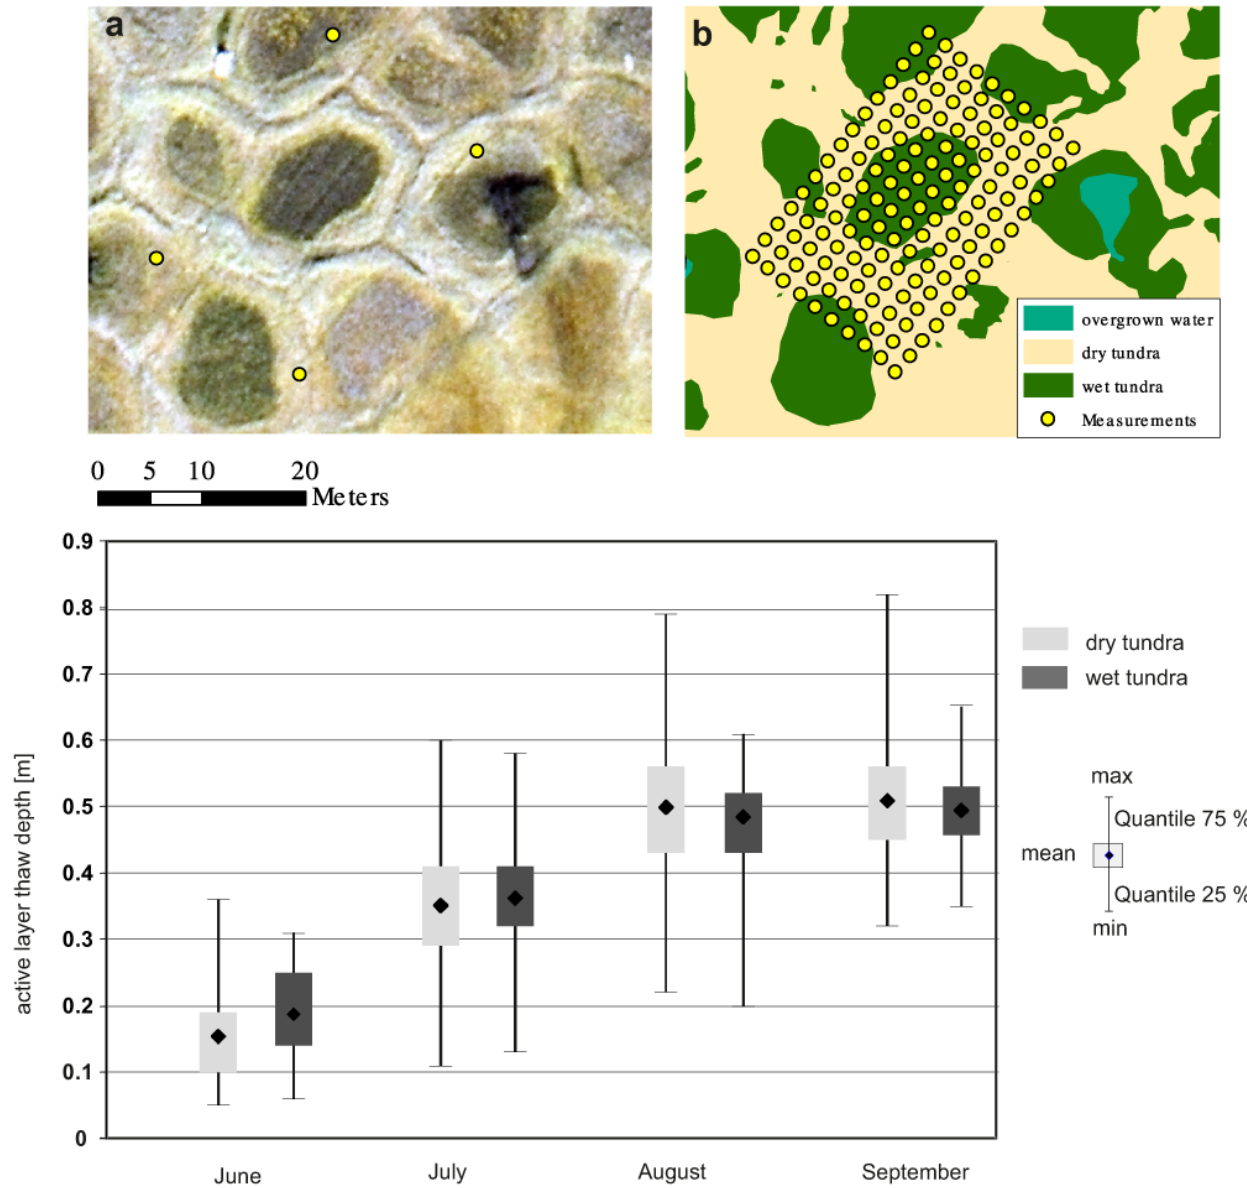
Fig. 12. Active layer thaw depth measurement sites since 2002. (a) Aerial image with 27.5 × 18m measurement grid (150 data points) marked by four outer grid points, (b) classification according to Muster et al. (2012), and (c) monthly statistics (June–September, 2002–2011) for active layer thaw depth, for dry and wet tundra classifications. The box plot shows summary statistics of mean, min./max. (whiskers), and 25 and 75% quantile ranges for each